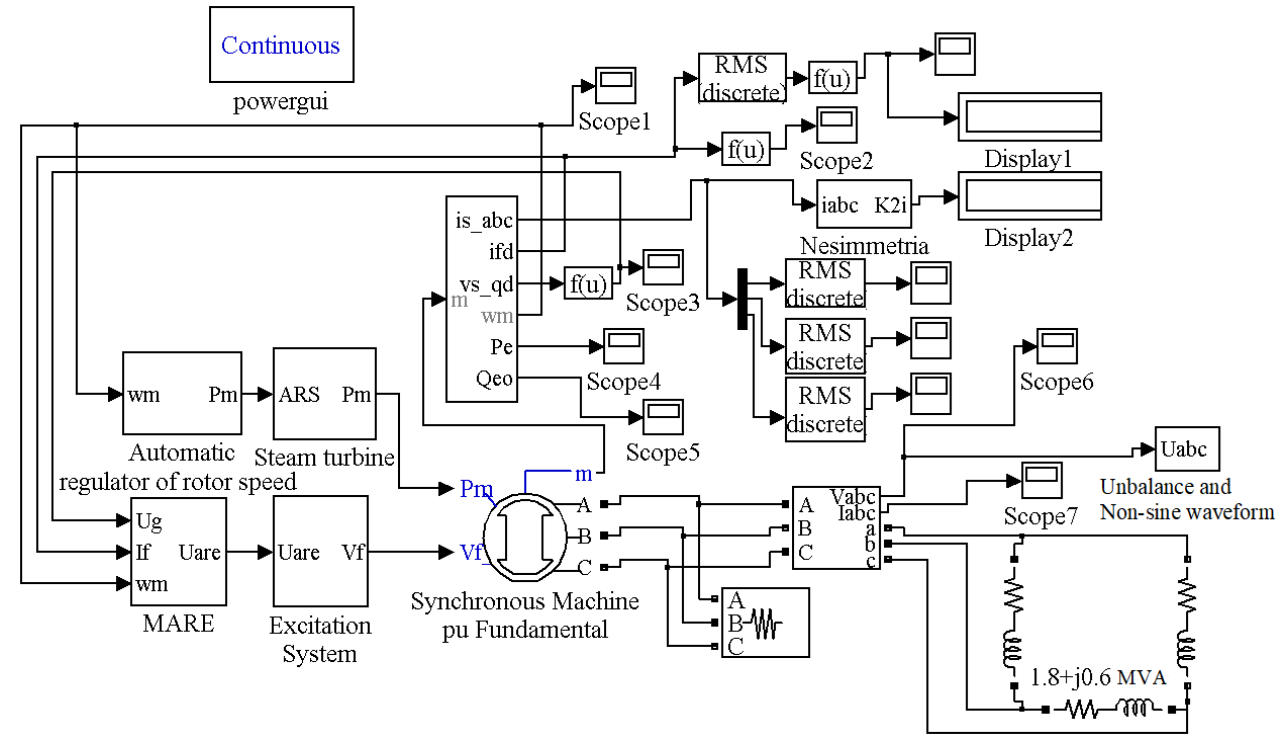
Figure 1. Flow chart of the MATLAB model of the generator serving an unbalanced load.